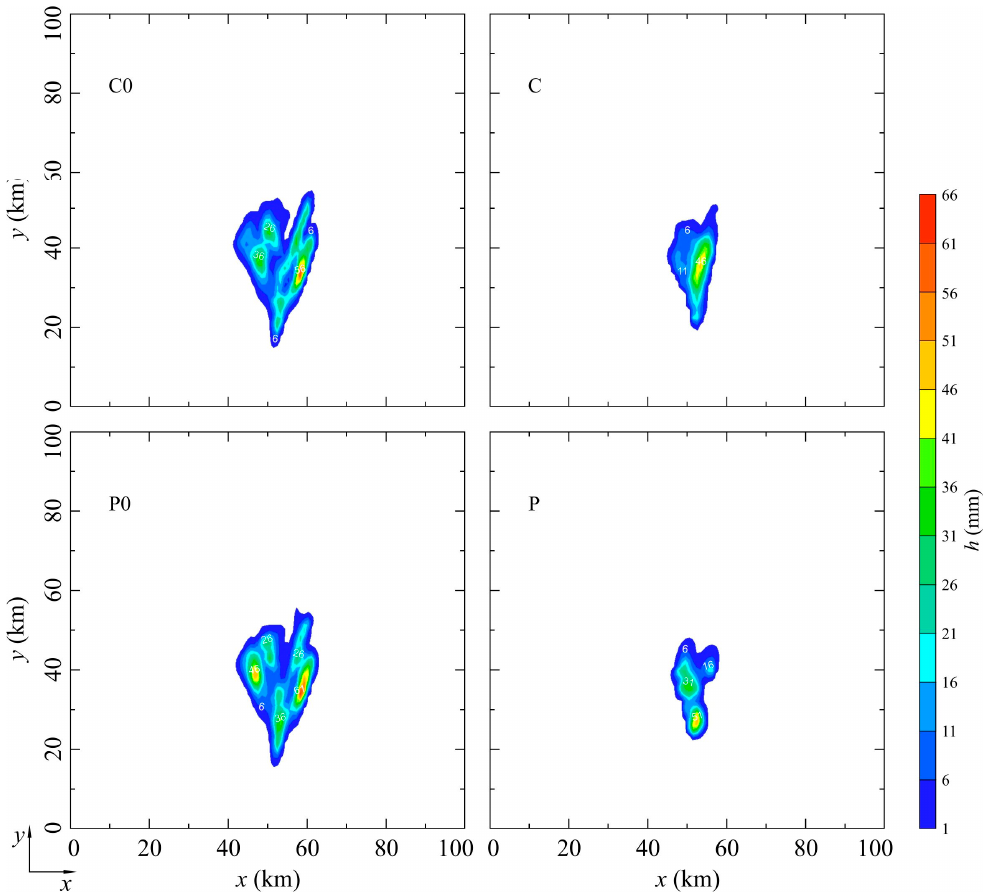
Figure 4. Horizontal distribution of the total surface precipitation at t = 120 min for the non-drizzle and drizzle cases. Isohyets are drawn in intervals of 5 mm; the base isohyet is 1 mm. The amount of surface precipitation is depicted using a scale on the right-hand side of the figure.